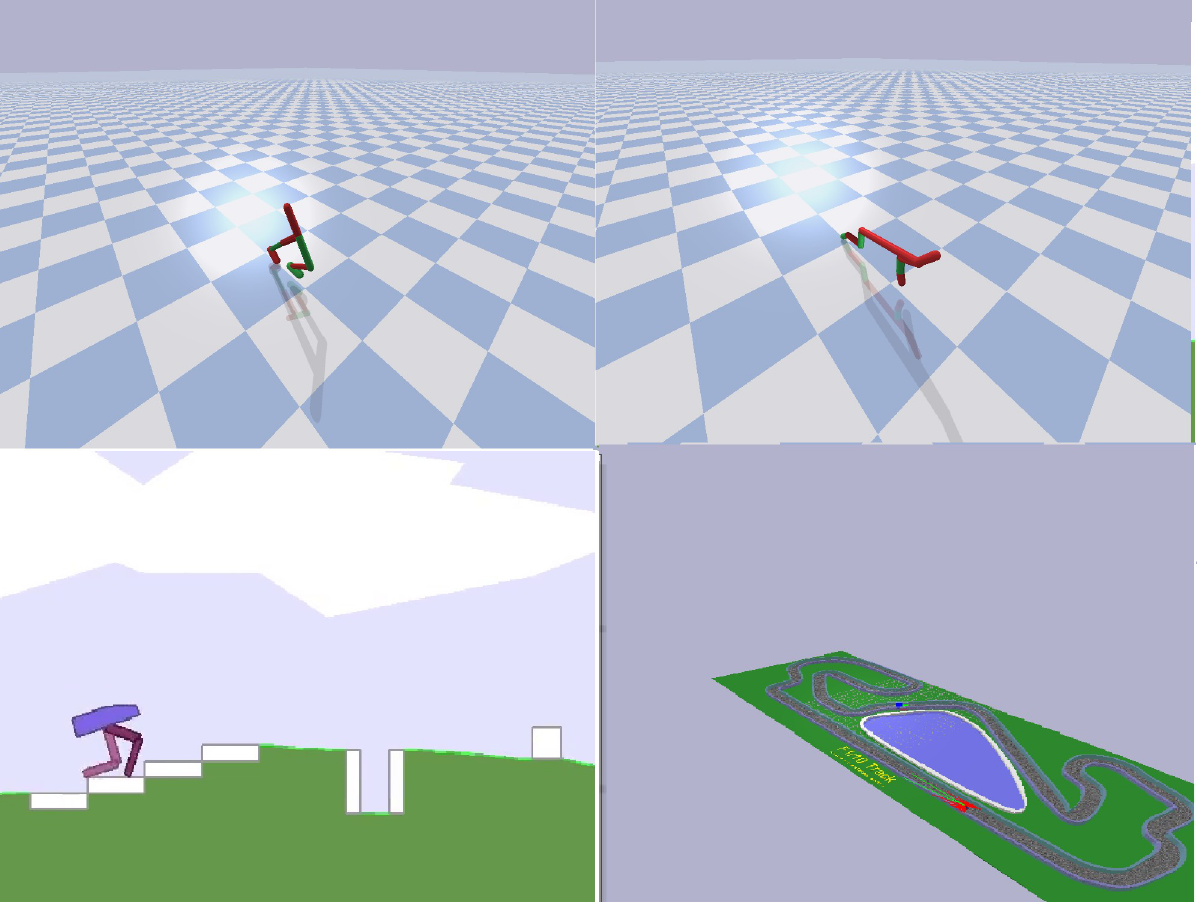
Fig 1. Illustration of the Walker2DBullet (top-left), HalfcheetahBullet (top-right), BipedalWalker (bottom-left), and MIT racecar (bottom-right) problems.